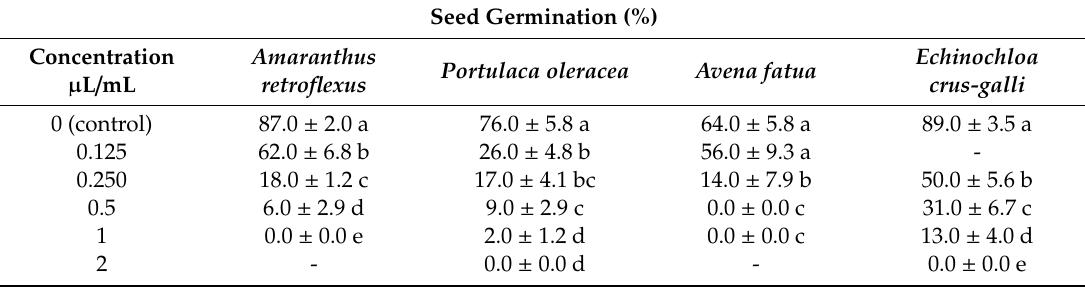
Table 5. Phytotoxic e ff ects of Thymbra capitata EO (TC4) on Amaranthus retroflexus , Portulaca oleracea , Avena fatua and Echinochloa crus-galli seed germination.